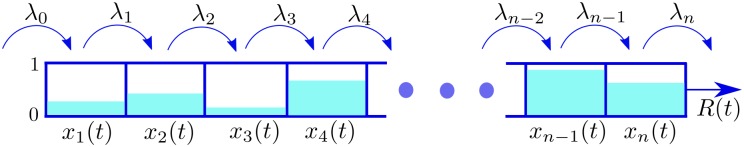
The RFM models unidirectional flow along a chain of n sites.The state variable xi(t) ∈ [0, 1] represents the density at site i at time t. The parameter λi > 0 controls the transition rate from site i to site i + 1, with λ0 > 0 [λn > 0] controlling the initiation [exit] rate. The output rate at time t is R(t) ≔ λn
xn(t).